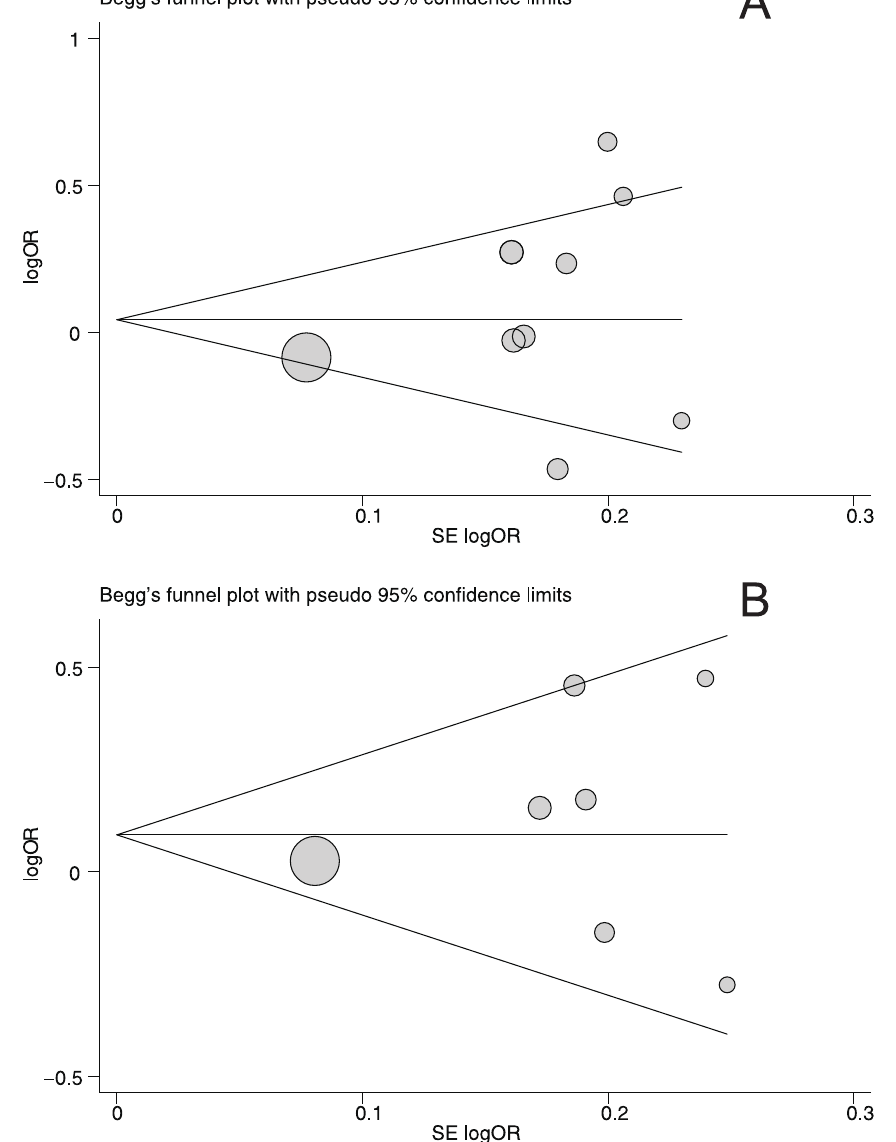
Figure 5. Begger’s funnel plot of the meta-analysis of ESR1 PvuII (A) and XbaI (B) polymorphisms with prostate cancer risk under dominant model. Each point represents a separate study for the indicated association. Log[OR], natural logarithm of OR. Horizontal line, mean magnitude of the effect. Note: Funnel plot with pseudo 95% confidence limits was used.